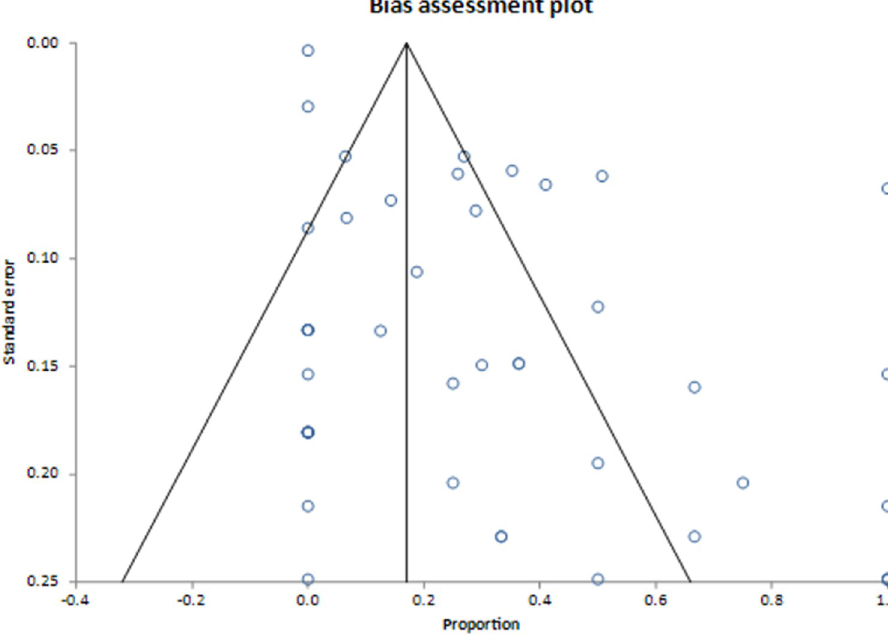
Fig 2. Bias assessment of meta-analysis of pooled proportion of infants with cCD with morbidity a . a Publication bias is considered present when there is asymmetry of the funnel plot.